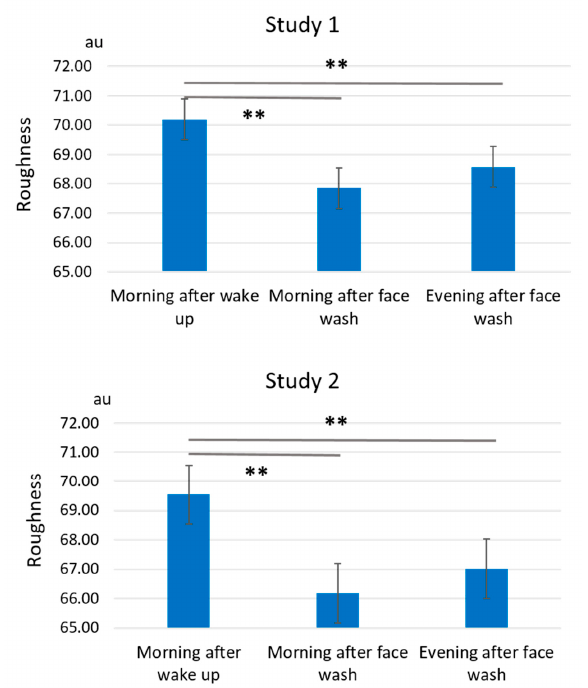
Figure 7. Daily fluctuation of roughness. Facial roughness is significantly larger during morning after wake ‐ up than that dur ‐ ing the morning after face wash or during the evening after face wash both in Studies 1 and 2 at the baseline period week ‐ 4 to week ‐ 1. **: p <